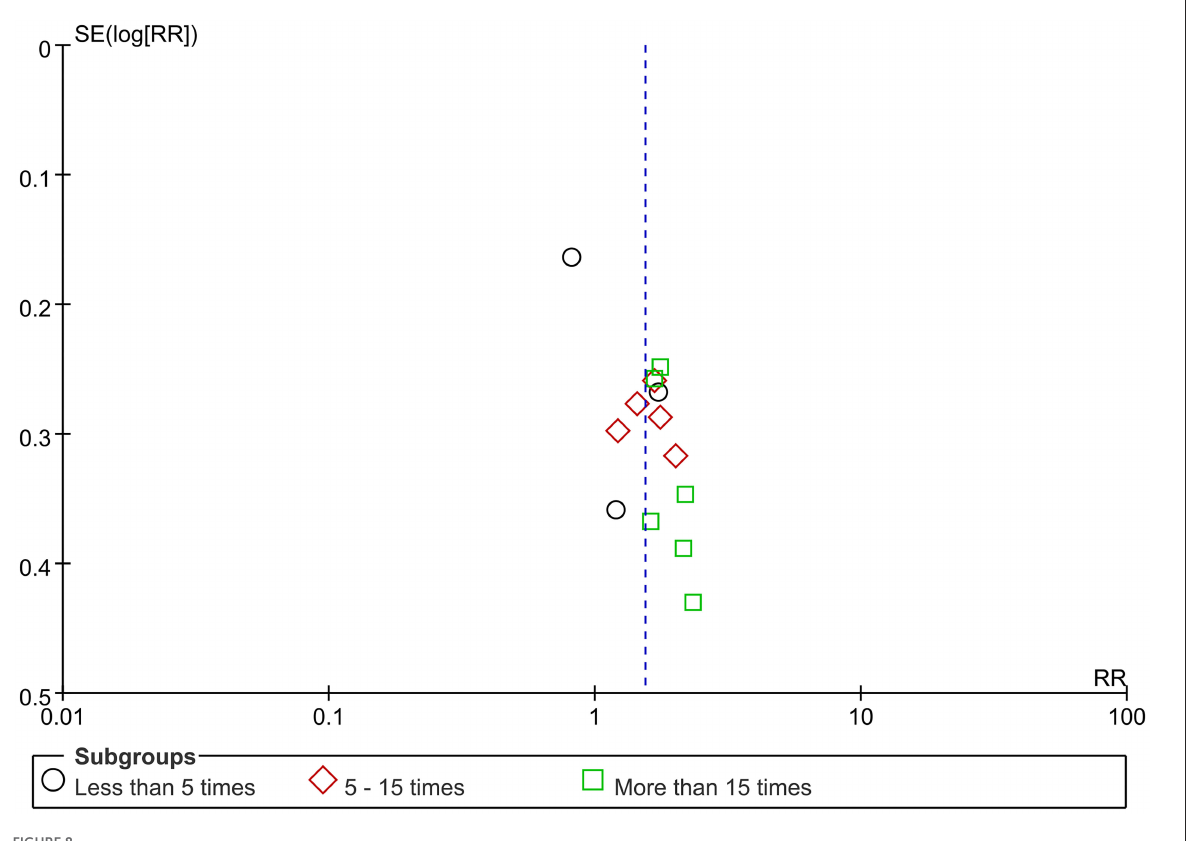
FIGURE8 Funnel plot of clinical pregnancy